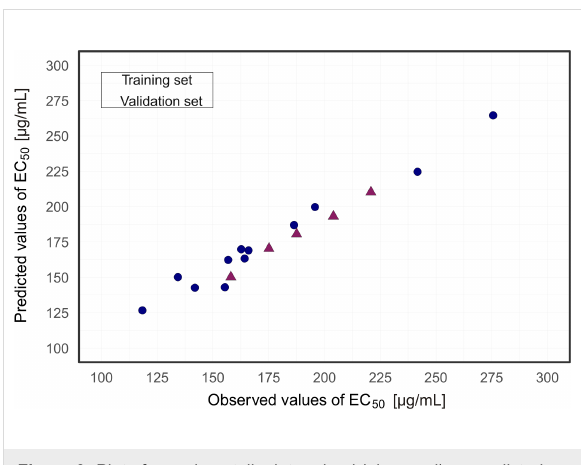
The developed nano-QSAR model was examined through a Y-scrambling test. We found that R 2 for randomization ranged from 0.21 to 0.55, while R 2 bagging ranged from 0.05 to 0.42 (Figure 4). The RMSE values for both randomized training and bagging sets were higher than 50.